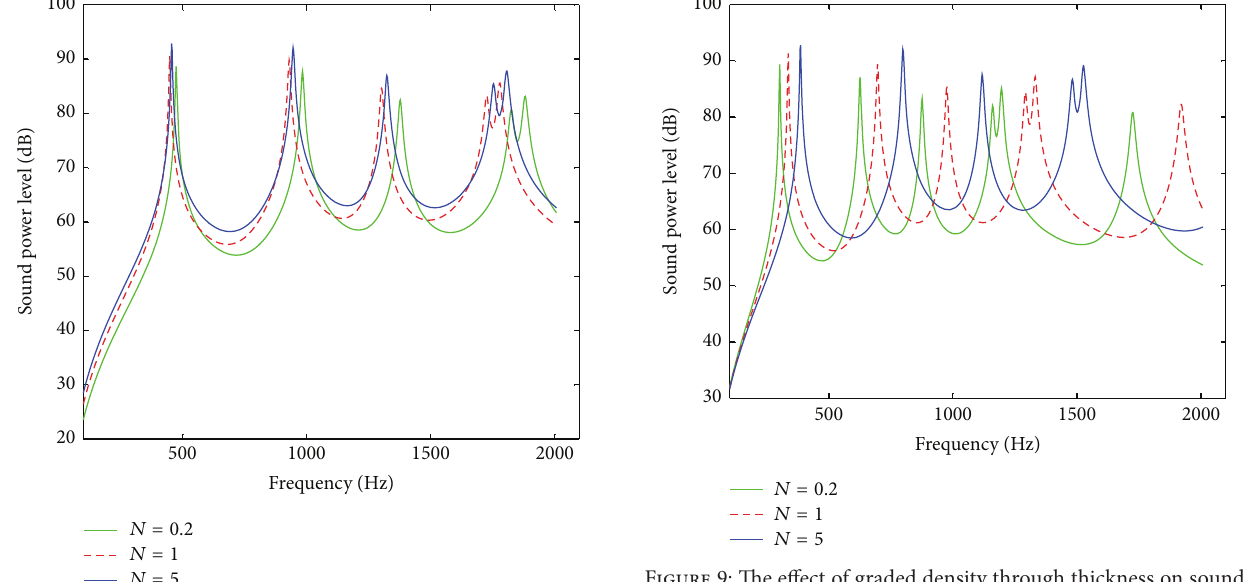
Figure 9: The effect of graded density through thickness on sound radiation of FGM plates.